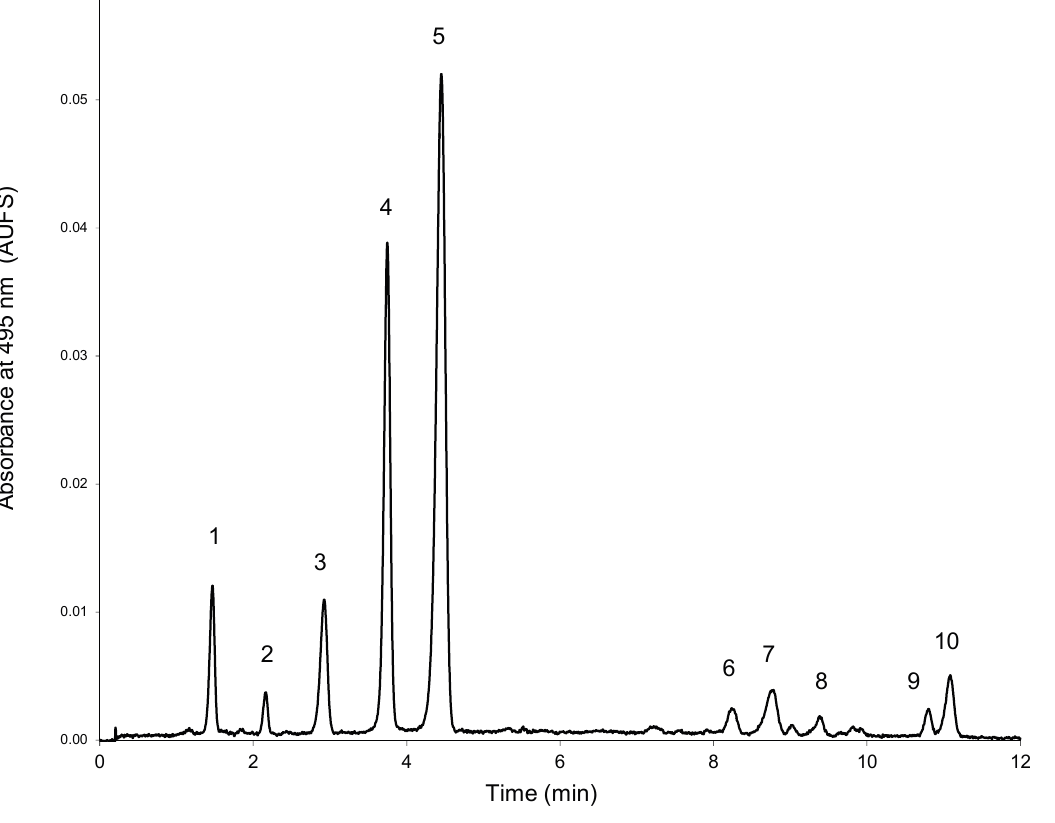
Figure 4. Typical chromatogram of the standardized extract. 1 : Delphinidin 3-glucoside; 2 : cyanidin 3-glucoside; 3 : petunidin 3-glucoside; 4 : peonidin 3-glucoside; 5 : malvidin 3-glucoside; 6 : peonidin 3-acetylglucoside; 7 : malvidin 3-acetylglucoside; 8 : malvidin 3-caffeoylglucoside; 9 : petunidin 3- p -coumaroylglucoside; 10 : malvidin 3- p -coumaroyl- glucoside ( trans